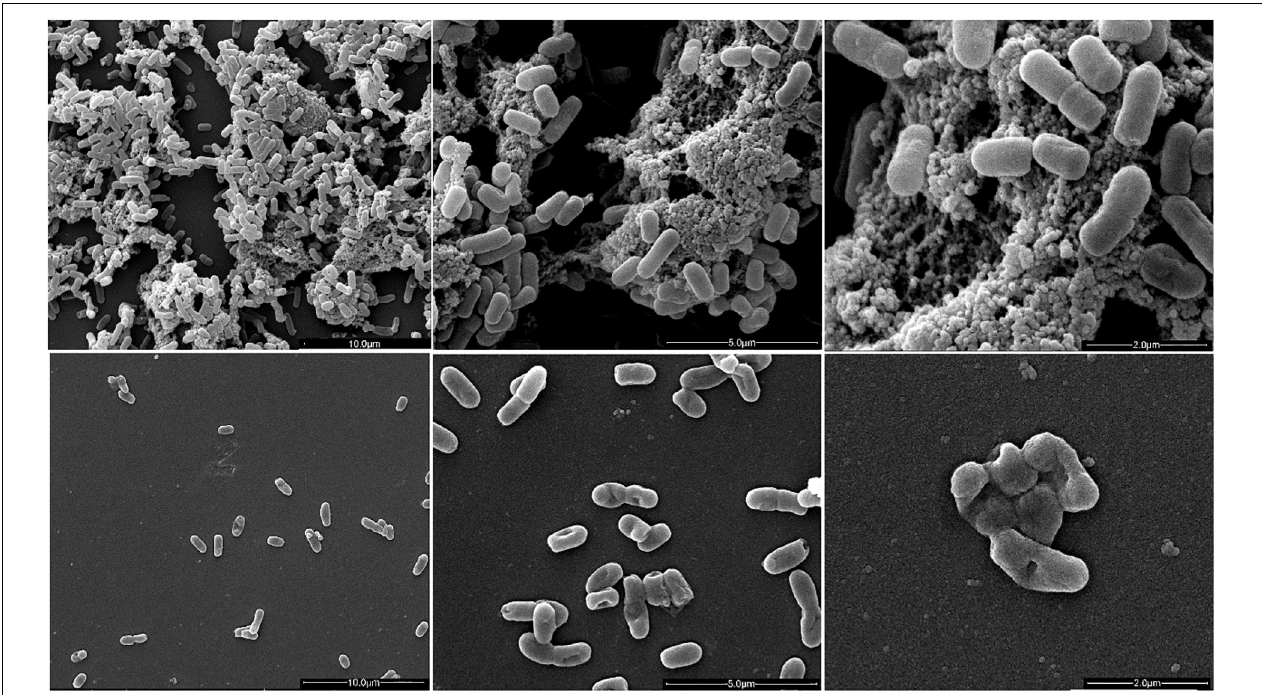
FIGURE 3 | Scanning electron micrographs (SEM). Above, control (not treated), large number of K. pneumoniae with intact appearance and high extracellular polysaccharide production. Below, K. pneumoniae treated with Fluopsin C (1 h), showing fewer microorganisms and bacteria presenting cell wall disruption, forming depressions in the configuration of the bacterial skeleton and lessened extracellular